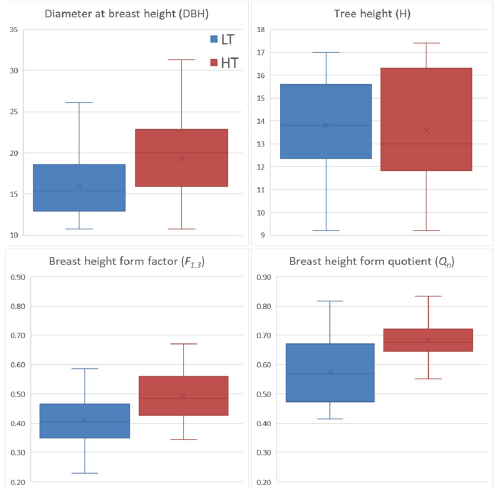
Figure 3. Box plot of the diameter at breast height (DBH), tree height (H), breast height form factor ( F 1.3 ), and the normal form quotient ( Q n ) of 17-year-old Liquidambar formosana trees in Hualien, Taiwan. HT = 600 trees ha − 1 ; LT = 1200 trees ha − 1 .